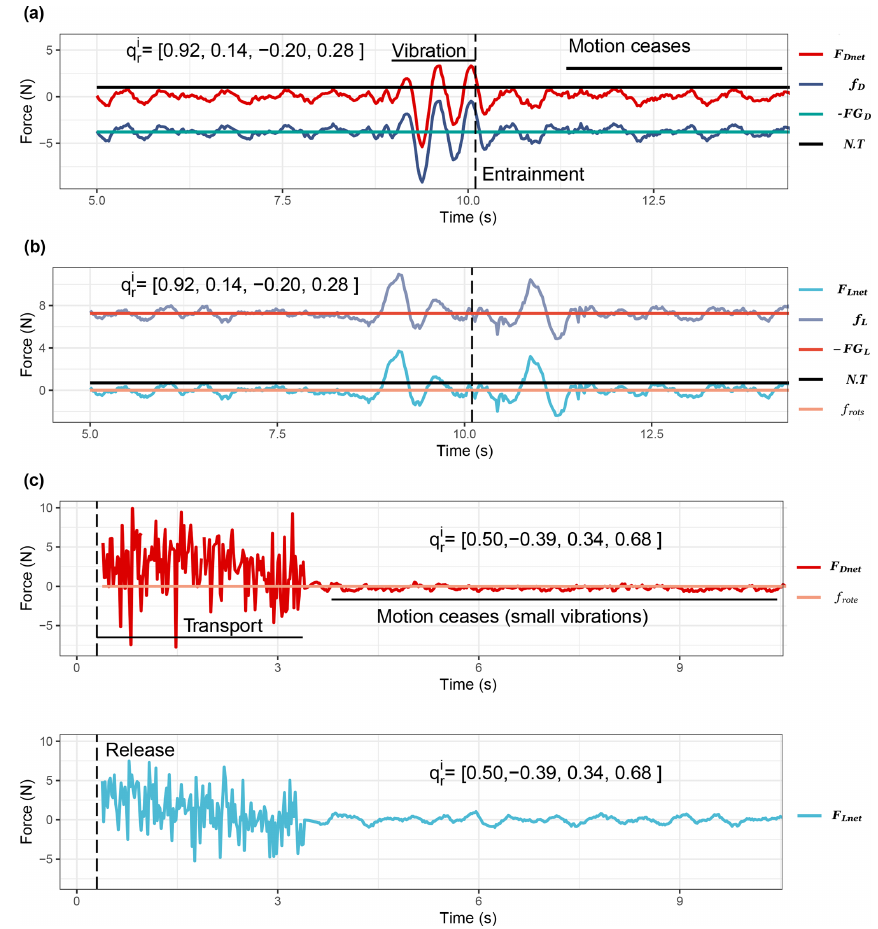
Figure 3. Example flume and field experiments (a, b) . Calculated drag (a) and lift forces (b) for the same flume experiment using the spherical sensor. The vectors F Dnet and f D record the magnitudes of the net force and the hydraulics–resistance interaction on the 2D plane parallel to the flume bed, respectively. The vectors F Lnet and f L record the net force and the hydraulic resistance interaction, respectively, along the normal to the flume bed direction. The gravitational components ( FG D = 3 . 7N and FG L = − 7 . 25N) were calculated using Eq. (4). The vertical dashed line ( t = 10 . 1s) shows the exact point of the entrainment of the particle as determined from the video recording. The N · T lines indicates the noise threshold of the accelerometer sensor; the calculated impulses concern sequences of point forces that exceed N · T . (c) Net drag forces recorded during one field experiment (Erlenbach). The vertical line indicates the time of 1s after the release of the sensor (see Sect. 3.3). The calculation of the tangential force magnitude ( f rot and f rot for the sphere and the ellipsoid, respectively) s e is based on Eqs. (C1) and